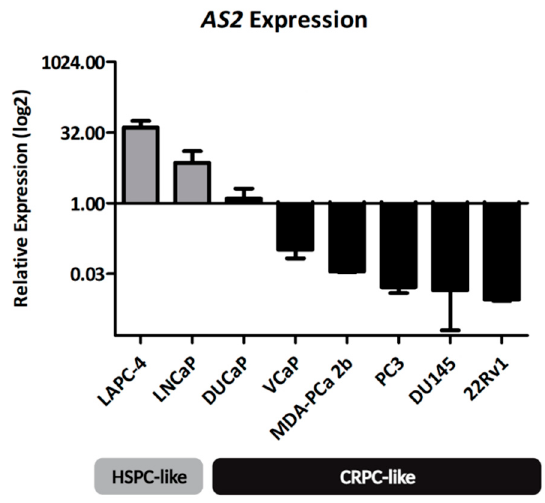
Figure 2. The expression of AS2 is high in HSPC-like cell lines, LAPC-4 and LNCaP, when compared to CRPC-like PCa cell lines.